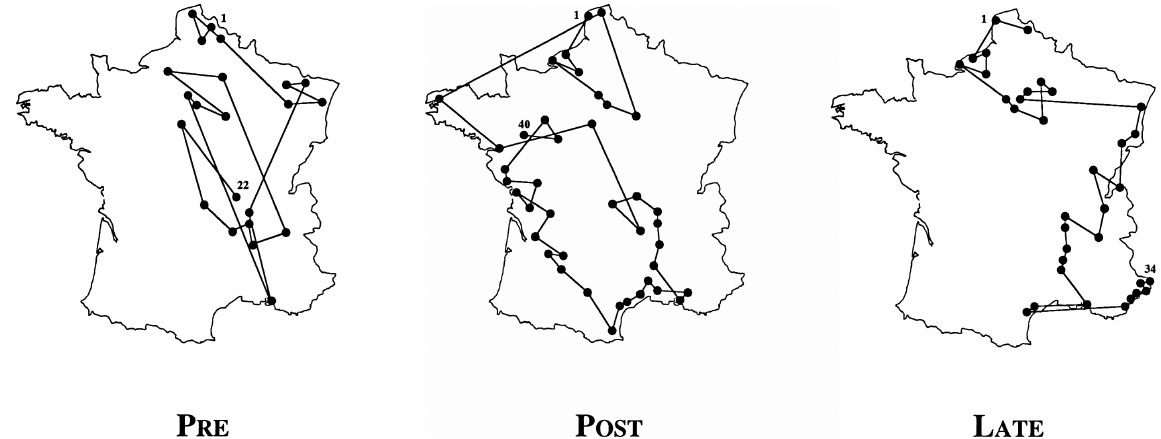
Fig. 4. Maps of France described from mental evocation in three conditions: prior to a prism exposure (Pre-test), immediately after removing the goggles (Post-test) and after a delay of about 24 hours following the prism exposure (Late-test). The filled circles indicate the geographical loci of the different responses and the bold number indicates the total number of responses. and the Late-tests ( χ 2 = 10 . 83, p < 0 . 001). The